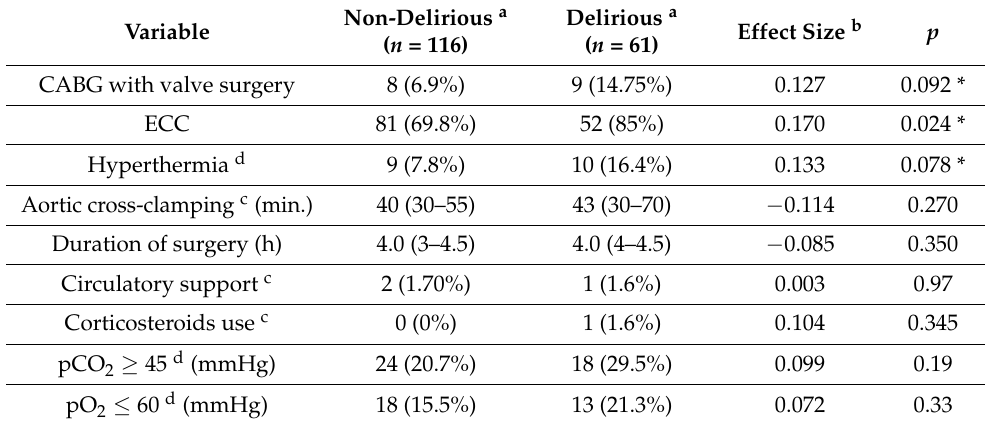
Table 3. Perioperative variables analyzed in univariate analysis.